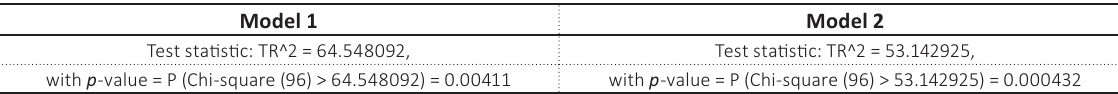
Table 7. Wooldridge test (auto correlation test) Model 1 Model 2